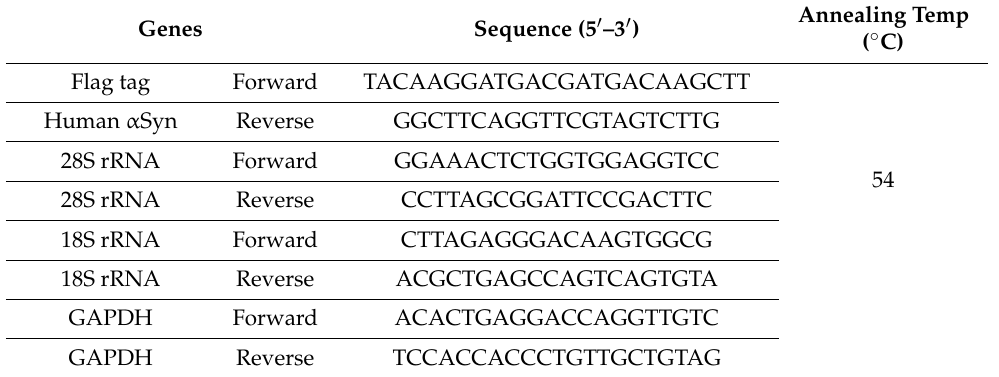
Table 2. The sequence of primers for the Flag-tagged α Syn and mouse genes.